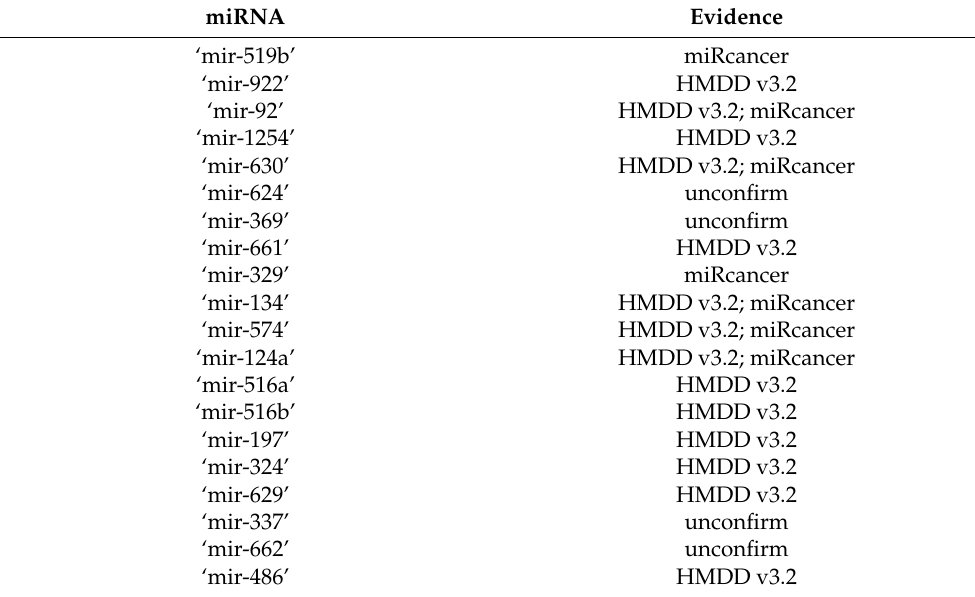
Table 2. TLNPMD was applied to BN to predict the top 20 disease-related